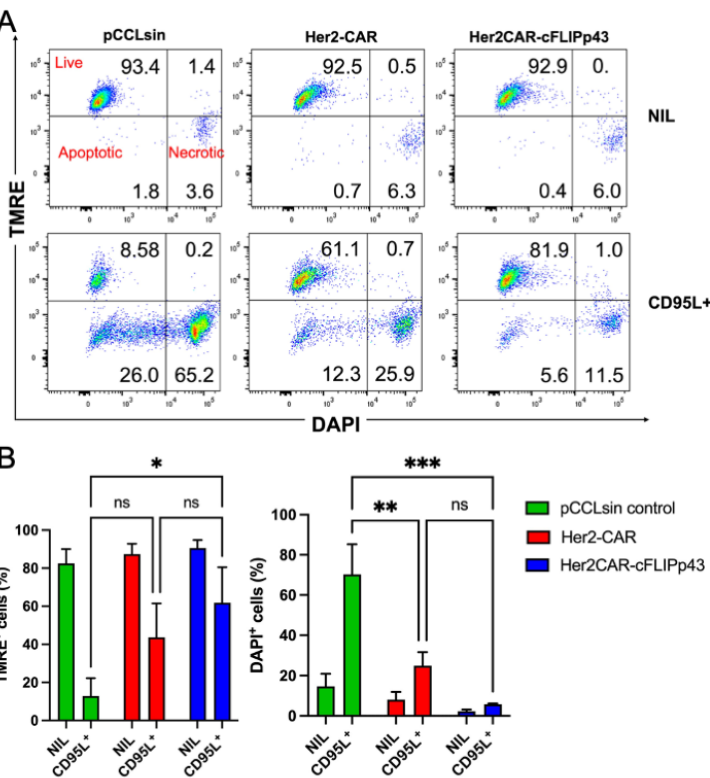
Figure 3. Impact of CD28 domain containing CAR and additional cFLIP-p43 expression on resistance to LZ-CD95L challenge. Primary human T cells transduced with pCCLsin control, Her2-CAR and Her2CAR-cFLIPp43 constructs were challenged with 0 µ g/mL ( A , B ) or 1 µ g/mL LZ-CD95L to mimic activation-induced cell death (AICD). CAR T cells were analysed 24 h post-challenge via TMRE and DAPI staining by flow cytometry. ( A ) Representative dot plots represent the GFP + gated